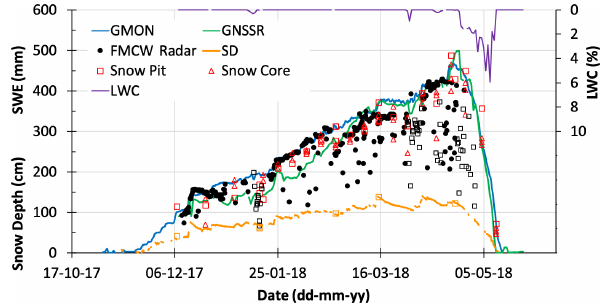
Figure 4. GMON- (blue line), FMCW-radar- (closed black circles) and GNSSr-derived (green line) water equivalent of snow cover (SWE, mmw.e.); snow depth (orange line for SR50AT-L data and orange open squares for in situ data) (SD, cm); and GNSSr-derived liquid water content (LWC, % volumetric, purple line, right scale), in comparison to in situ snow pit (open red square) and snow core (open red triangle) SWE measurements at the NEIGE-FM site for the winter season of 2017–2018. For FMCW radar data (in black), plain circles are for dry snow, while open squares correspond to wet